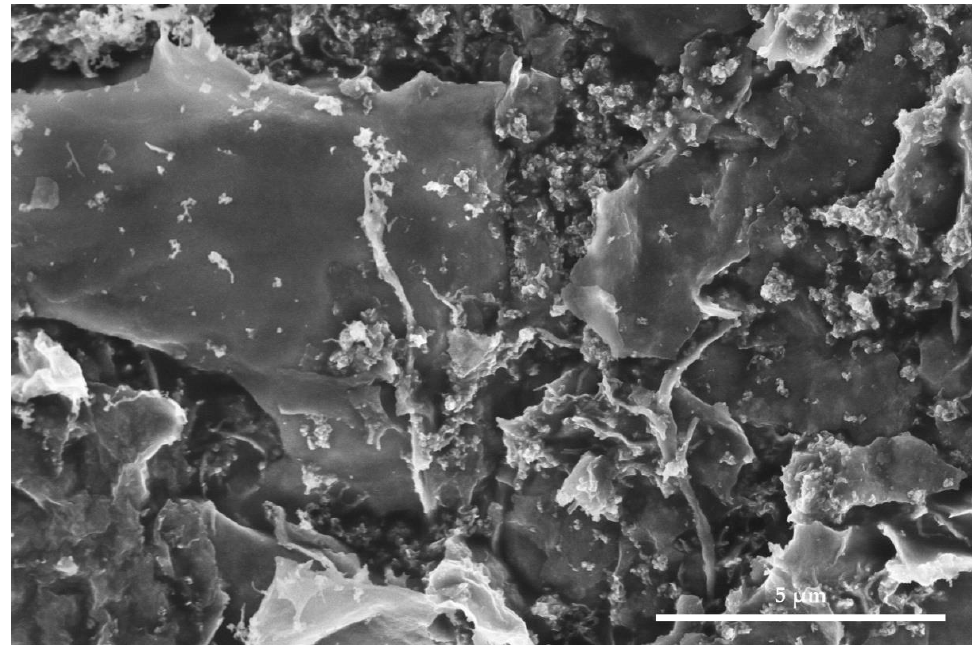
Figure 2. Titanium dioxide planar amorphous particle. Secondary electron photography. Magnifi- cation ×25,000 [27] . Phot. S. Svorová Pawełkowicz. tion × 25,000 [27]. Phot. S. Svorov á